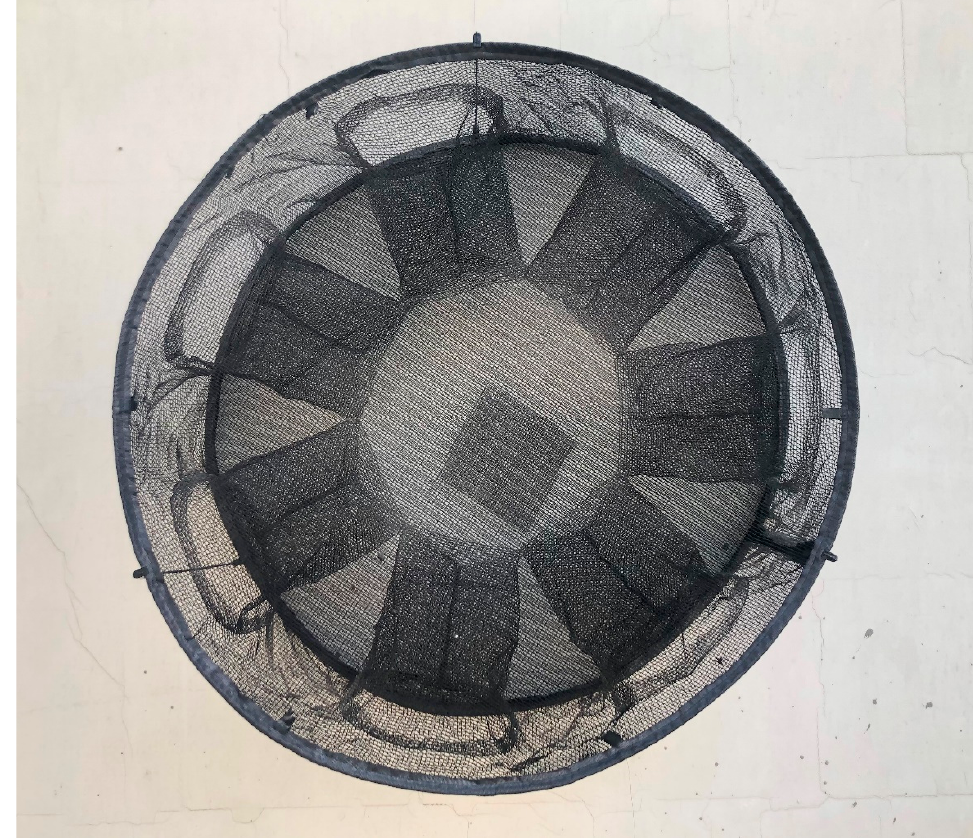
Figure 1. A top-down view of an experimental seven-entrance trap. Black square around the center of the bottom panel is the position for setting a bait box.